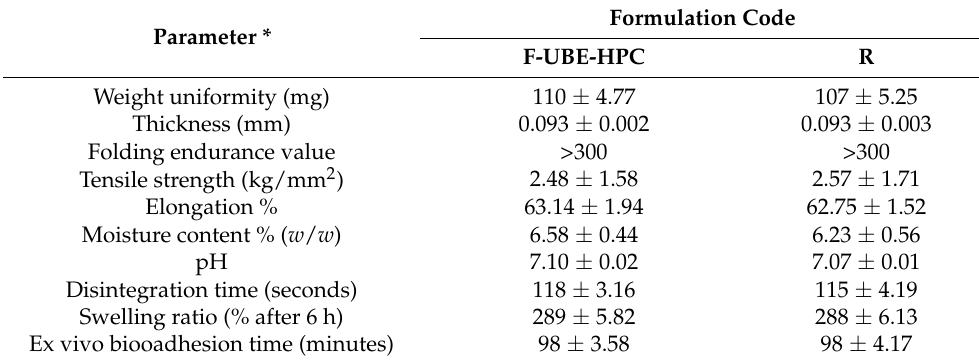
Table 3. Bioadhesive oral films’ pharmacotechnical